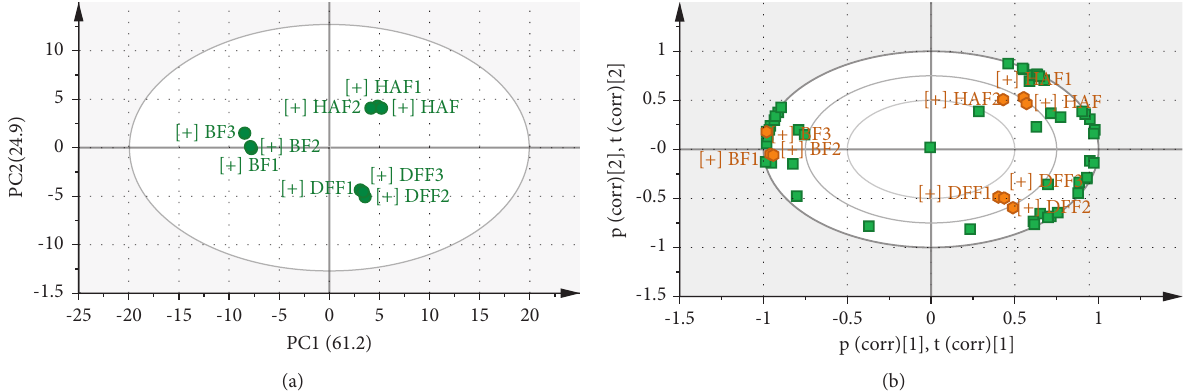
Figure 6: PCA score and biplot diagram of volatile flavor compounds of giant salamander meatball before and after two frying methods. (a) Score plot; (b) biplot